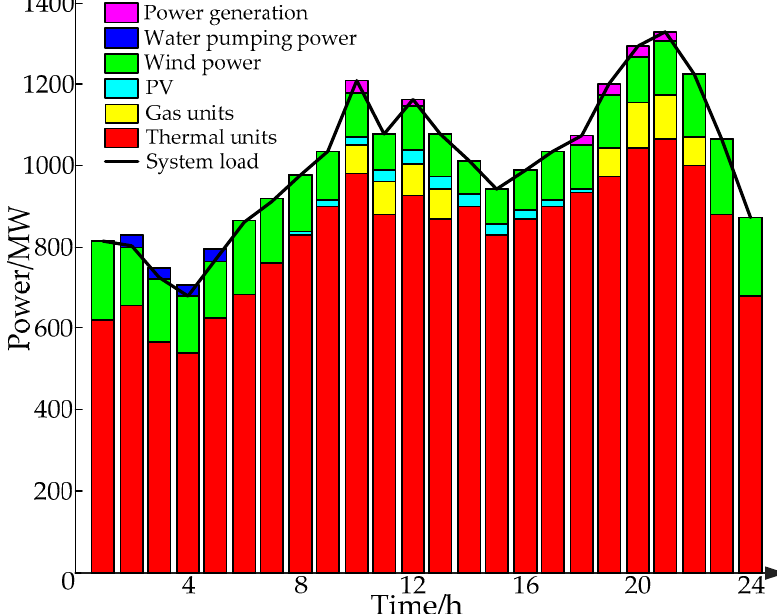
Figure 9. Output of each power source under ordinary operating condition.